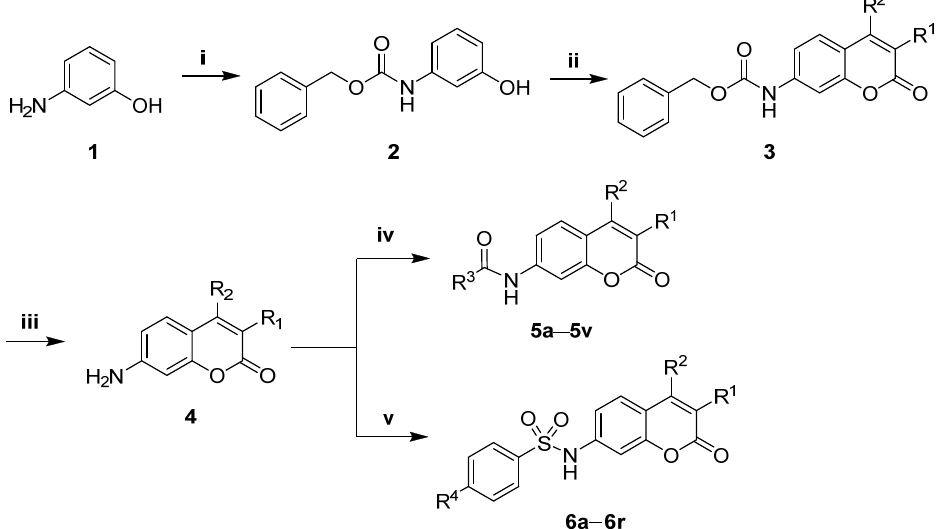
Table 1. Structures and yields of compounds 5 .